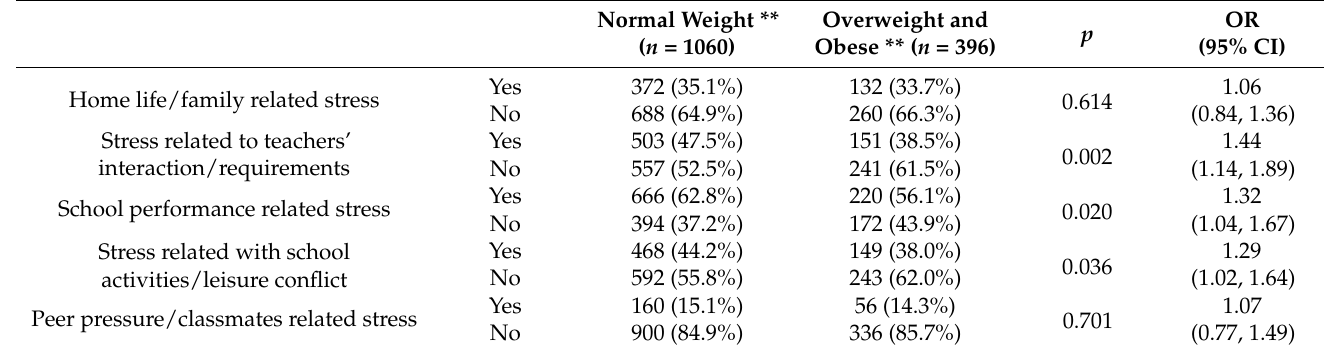
Table 2. The association between sources of children’s stress and weight